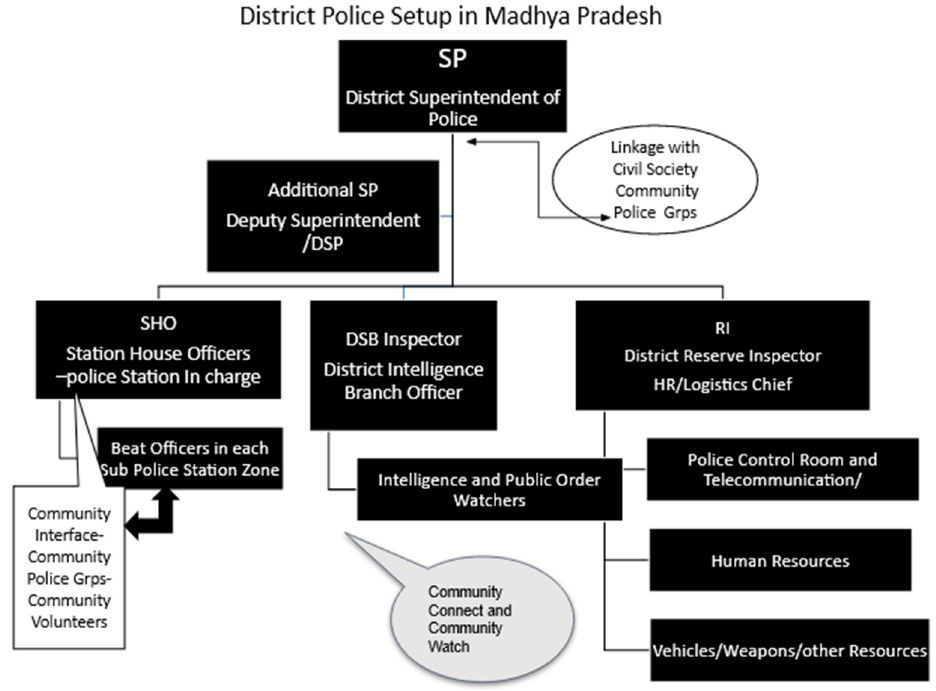
Figure 1. District Level Police Structure.